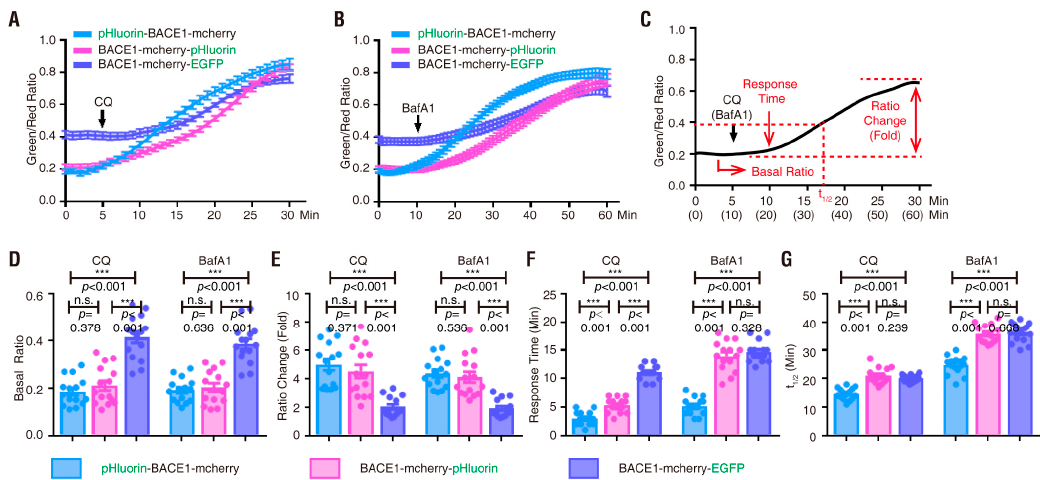
Figure 4. Summary of BACE1 fusion proteins in response to CQ and BafA1 in NLT cells ( A ) Quantification analysis of the green / red ratio of three BACE1 fusion proteins in response to CQ. ( B ) Quantification analysis of the green / red ratio of three BACE1 fusion proteins in response to BafA1. ( C ) Illustration of the term “Basal ratio,” “Ratio change (fold),” “Response time” and “t 1 / 2 .” ( D ) Quantification analysis of the “Basal ratio” of three BACE1 fusion proteins in response to CQ and BafA1. Significance was calculated with one-way ANOVA with LSD post hoc test; n.s. p > 0.05, *** p < 0.001. ( E ) Quantification